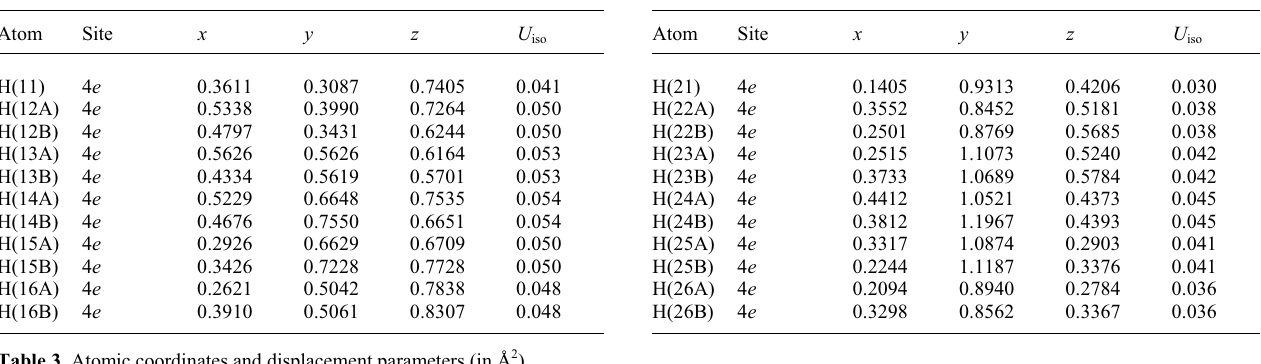
Table 2. Atomic coordinates and displacement parameters (in Å 2 )